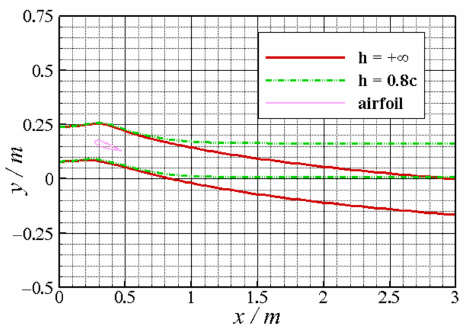
Figure 24. Comparisons of jet boundary with and without the ground